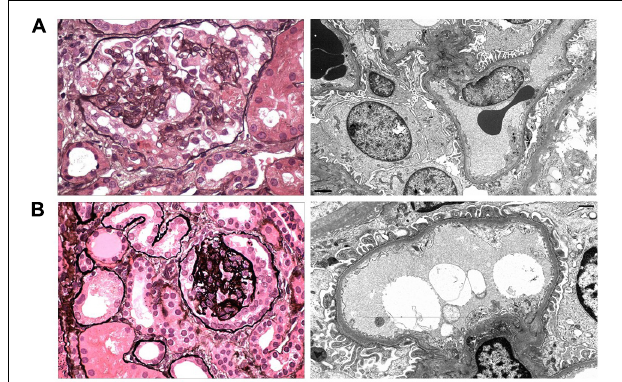
FIGURE 1 | Representative images of the kidney biopsies from Patient 1 (A) and Patient 2 (B) are shown. (A) A representative glomerulus has segmental collapsing sclerosis with implosive wrinkling and collapse of glomerular capillary walls and hypertrophy and hyperplasia of the overlying glomerular epithelial cells (Jones methenamine silver, × 600). Electron microscopy shows irregular (40%) foot process effacement with swollen podocyte cell bodies and open-appearing cytoplasm with reduced organellar content ( × 6,000). (B) There is focal global tuft collapse with a corona of hyperplastic glomerular epithelial cells and focal podocyte shedding and apoptosis (Jones methenamine silver, × 600). Electron microscopy reveals mild (25%) foot process effacement ( × 10,000).